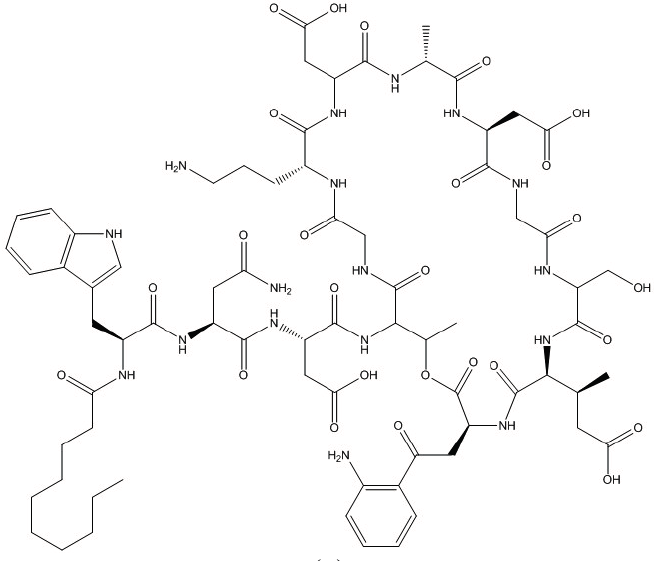
( c ) Quinupristin and dalfopristin binding to the 50S ribosomal subunit in relation to the p -site tRNA and the ribosomal exit tunnel (highlighted in gold). Adapted from [84]; ( d ) Inhibition halos induced by B. megaterium CLP against a sensitive B. cereus strain at different pH values and in the